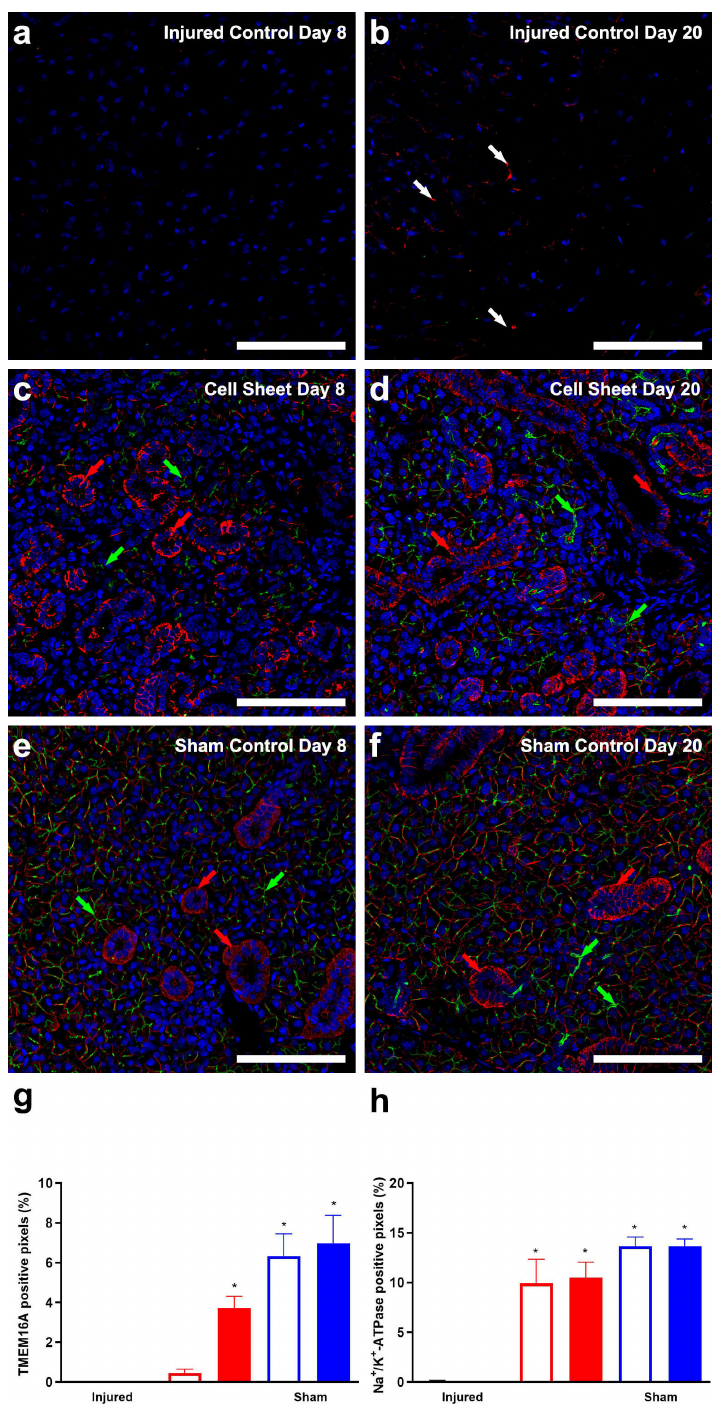
Figure 5. Cell sheets promote expression of ion transporters: injured SMG ( a , b ); injured SMG treated with cell sheets ( c , d ); and sham controls ( e , f ). Tissue samples were incubated with rabbit anti-TMEM16A ( a – f ) (green) and mouse anti-Na + / K + -ATPase ( a – f ) (red) antibodies and analyzed using a Zeiss LSM 700 confocal microscope, with data representing results from five experiments and white bars indicating 100 µ m. Positive areas of TMEM16A ( g ) and Na + / K + -ATPase ( h ) fluorescence were captured using ImageJ software. Data are expressed as means ± SD of results from five independent experiments, where statistical significance was assessed by one-way ANOVA ( p < 0.05) and Dunnett’s post-hoc test for multiple comparisons to injured controls (open bars: Day 8; closed bars: Day 20); * significant di ff erence from injured controls. Green and white / red arrows indicate TMEM16A and Na + / K + -ATPase expression,